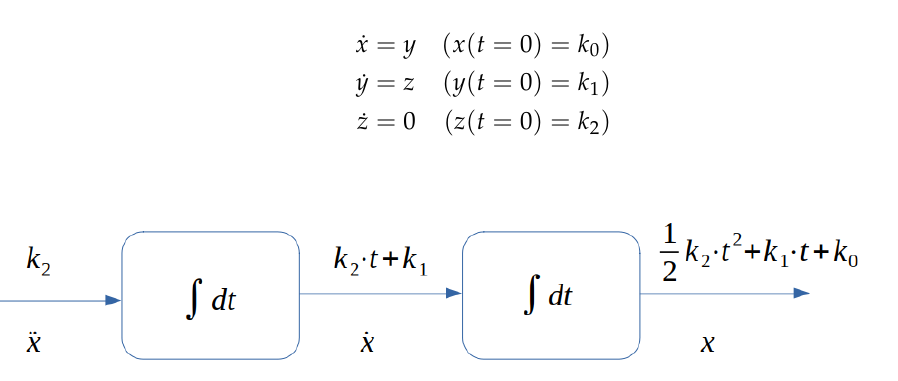
Figure 4. Basic implementation scheme of a second order ODE with constant input and initial conditions ( ¨ x , ˙ x , x ) = ( k 2 , k 1 , k 0 ). The analytical solution is also provided at the end of each stage.